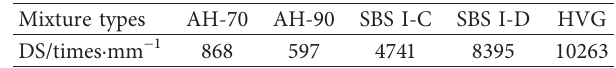
nr0.1 . (b) J nr3.2 . (c) R 0.1 (d) R 3.2 . (e) J nrdiff (f) J nrslope . Table 5: Rutting test results of asphalt